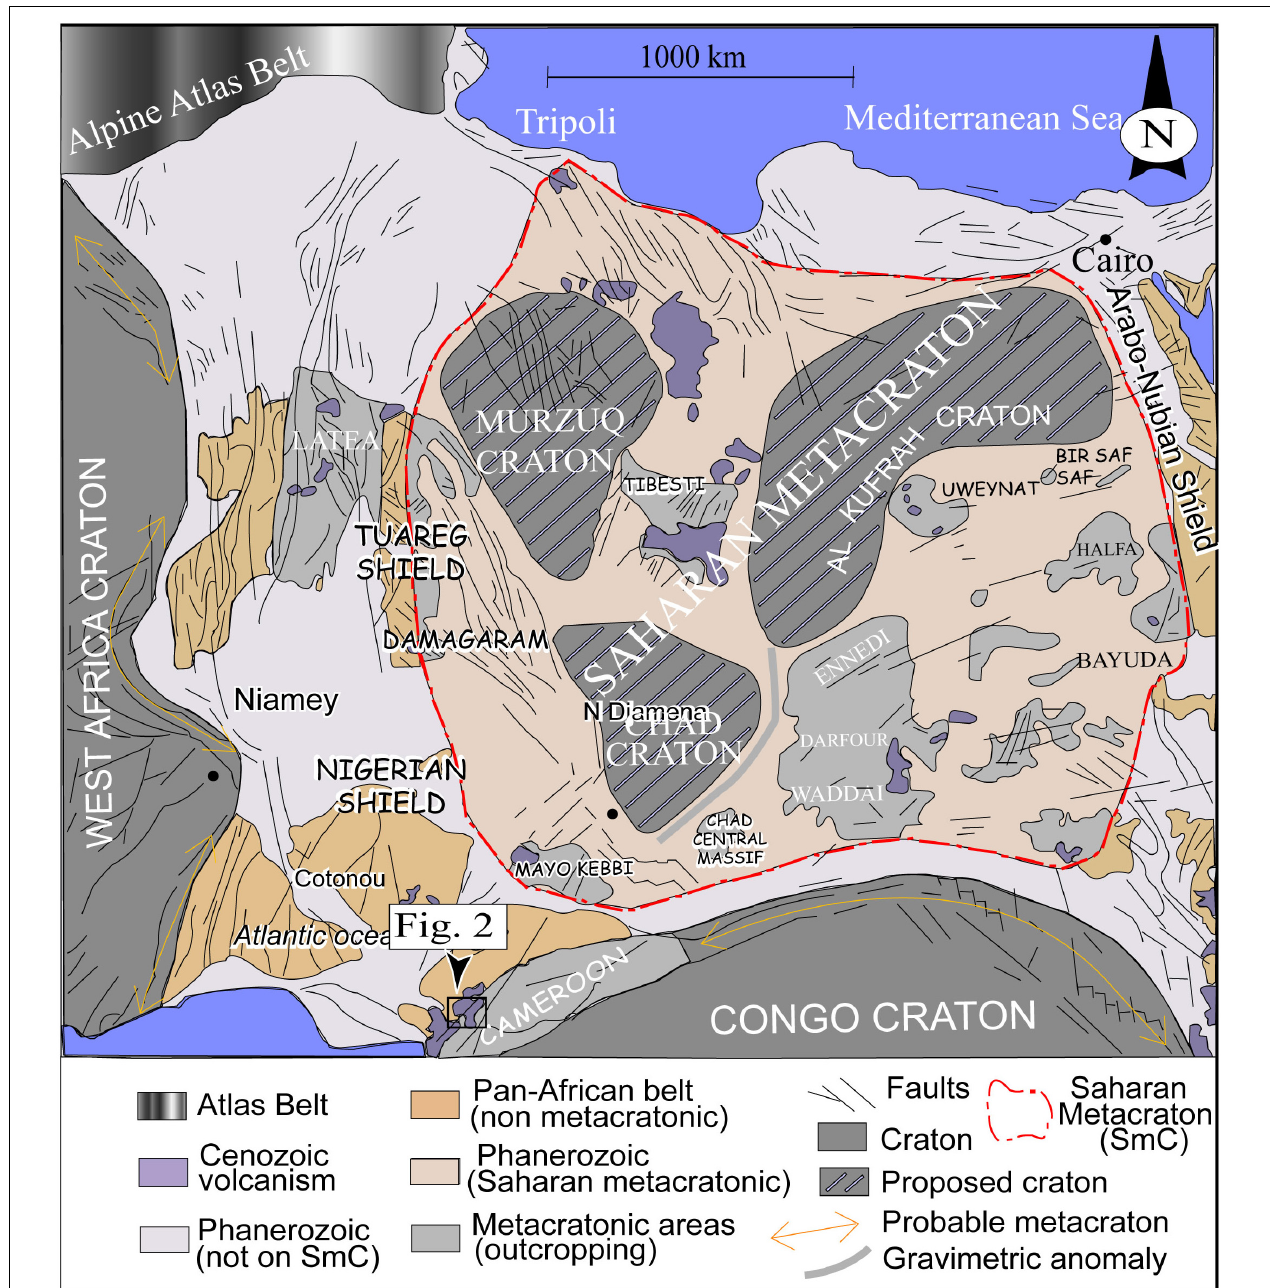
FIGURE 1 | Geological sketch map of west-central Africa with cratonic areas and the Pan-African–Brasiliano provinces of the Pan-Gondwana belt in a Pangea reconstruction; modified from Castaing et al. (1994) and Abdelsalam et al. (2002) after Liégeois et al. (2013).